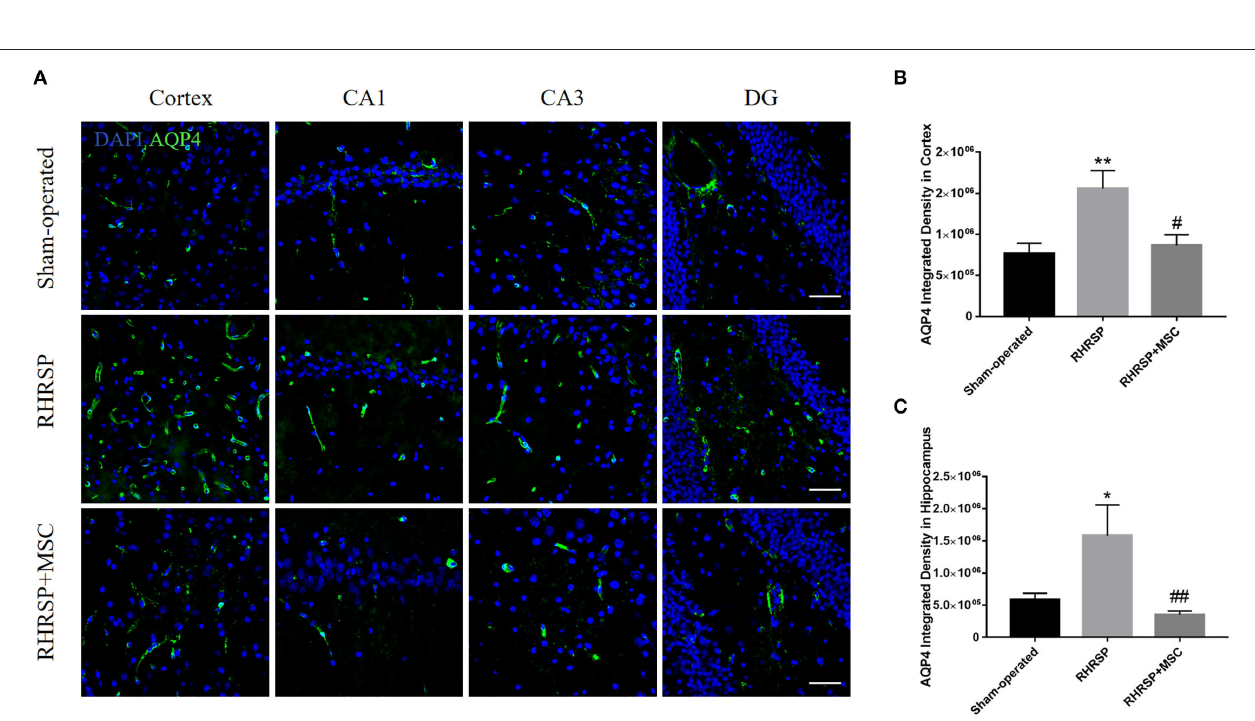
FIGURE 4 | Effects of MSCs on A β 1-42 accumulation. (A) Immunofluorescent staining of A β 1–42 in three groups. (B,C) Quantification of A β 1–42 fluorescence intensity in the cortex and hippocampus (*** P < 0.001, vs. sham-operated group; # P < 0.05, vs. RHRSP group; n = 6/group). scale bar = 50 µ m. * P < 0.05, vs. sham-operated group.